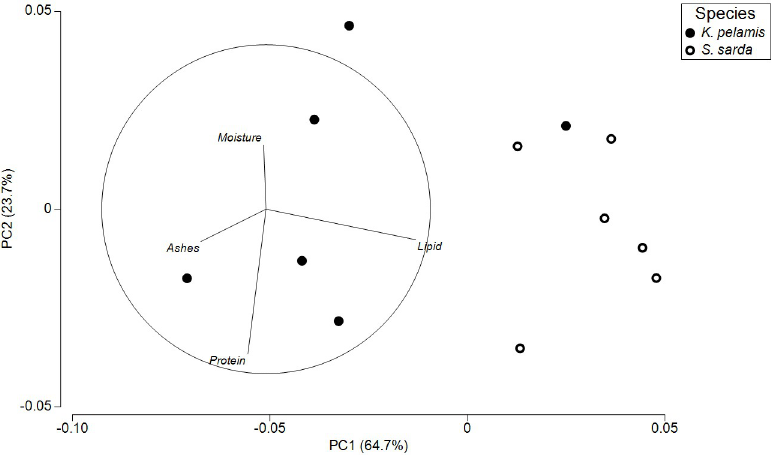
Fig 3. Body composition PCA analysis. Principal Component Analysis (PCA) of body proximate composition of Katsuwonus pelamis and Sarda sarda .